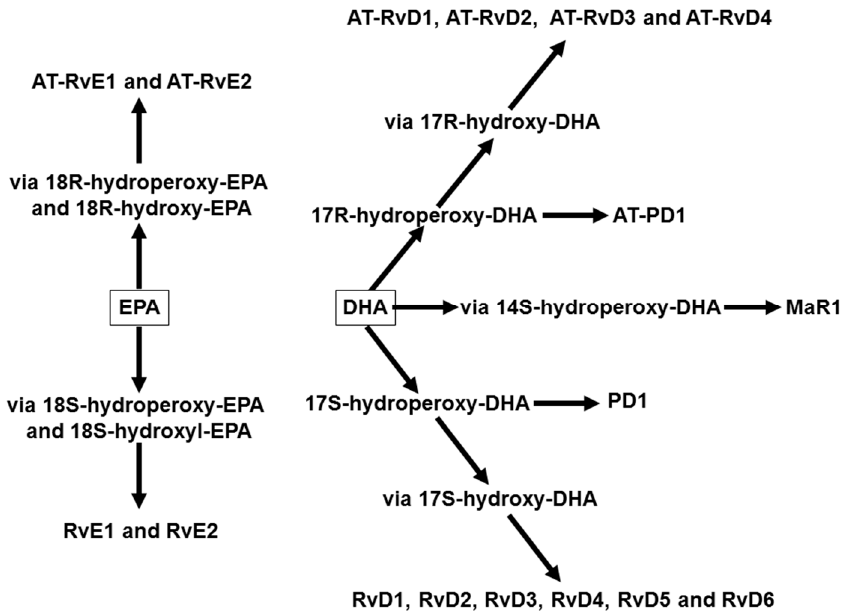
Figure 4. Overview of the pathways of synthesis of specialised pro-resolving mediators from eicosapentaenoic acid (EPA) and docosahexaenoic acid (DHA). Abbreviations used: AT, aspirin-triggered; MaR, maresin; PD, protectin D; Rv, resolvin.